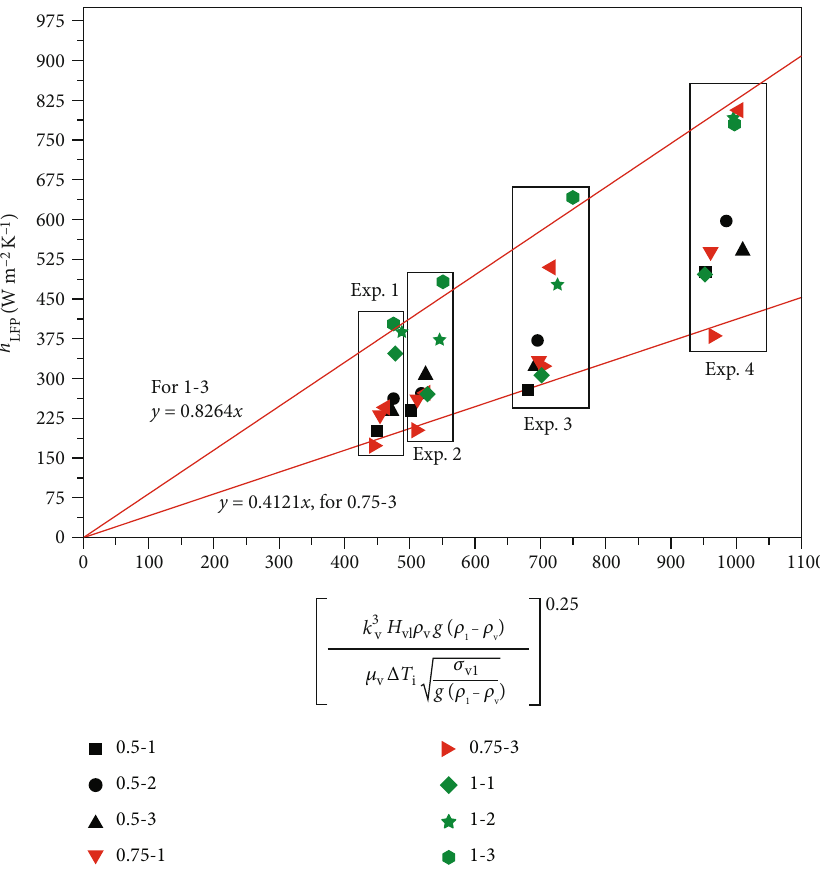
Figure 15: Correlation on h